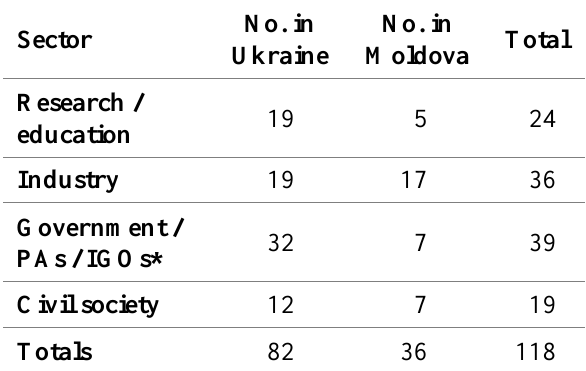
Table 5. Organisations related to wetland biomass utilisation in the ReedBASE study sites. Source: ReedBASE